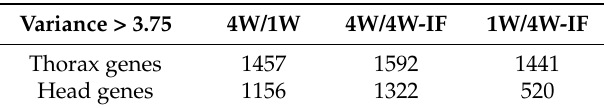
Table 2. Variance Changes * with Age and